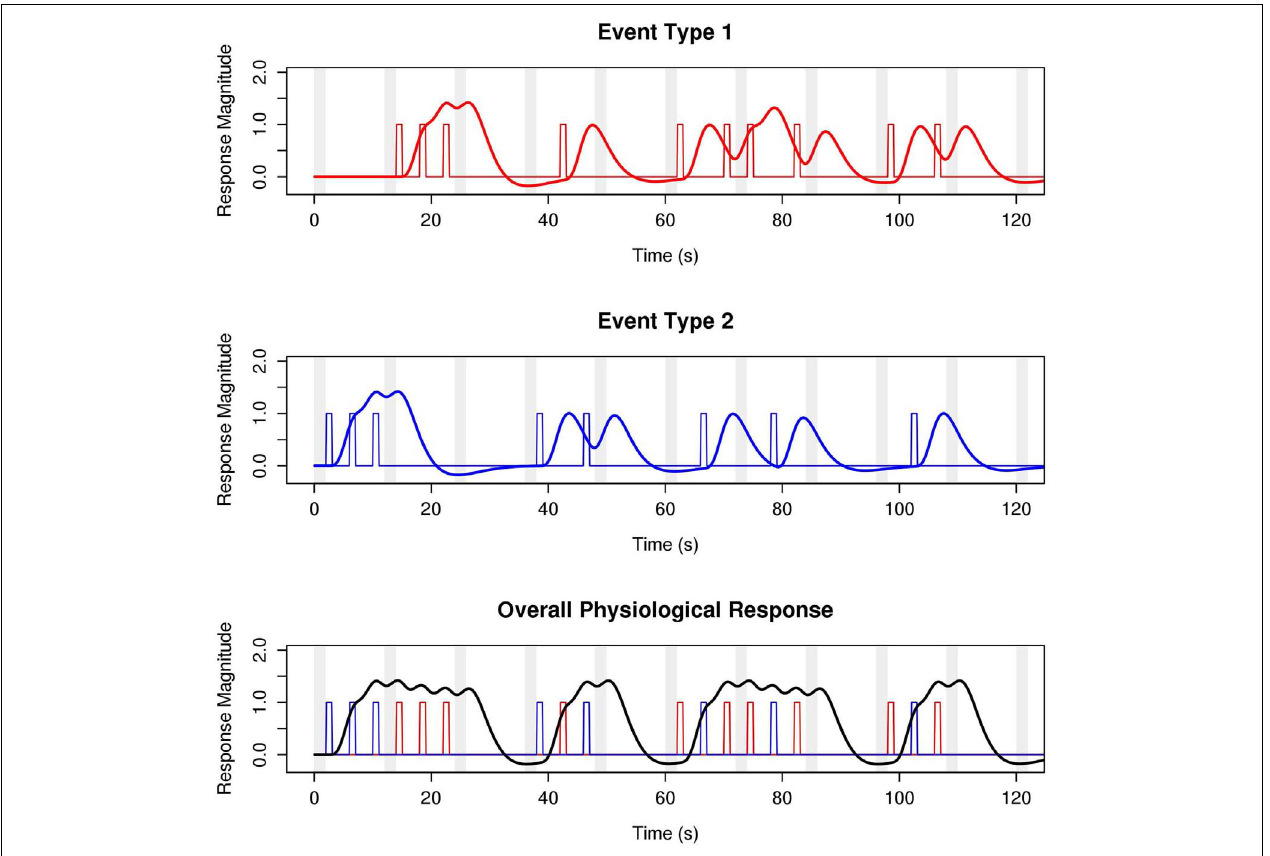
limiting sparse experiments block or slow event-related designs.The HRF-convolution approach we advocate in this paper allows for rapid event-related sparse-sampling fMRI experiments. Legend: red/blue distinguish event types; colored vertical bars denote stimulation events; red and blue curves show the canonical hemodynamic response to these events; the black curve shows the aggregate response across event types; vertical gray bars indicate time of MR signal acquisition;TR = 12s;TA = 2s; ISI =